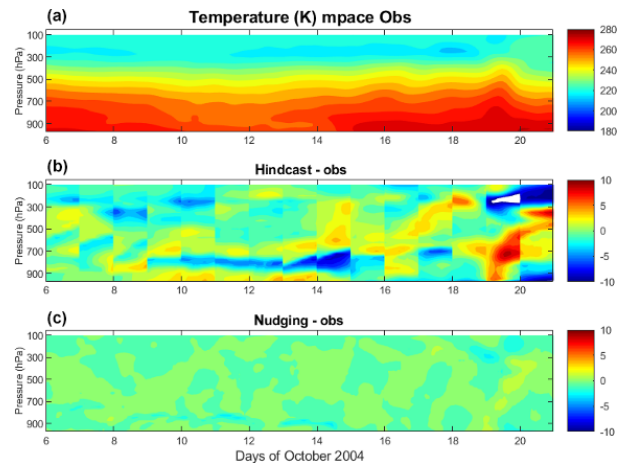
Figure 5. Vertical evolution of temperature from observations (a) for the period during the MPACE field campaign. Also displayed are the temperature biases for the E3SM SCM run in hindcast mode (b) and for E3SM SCM run with nudging (c) .